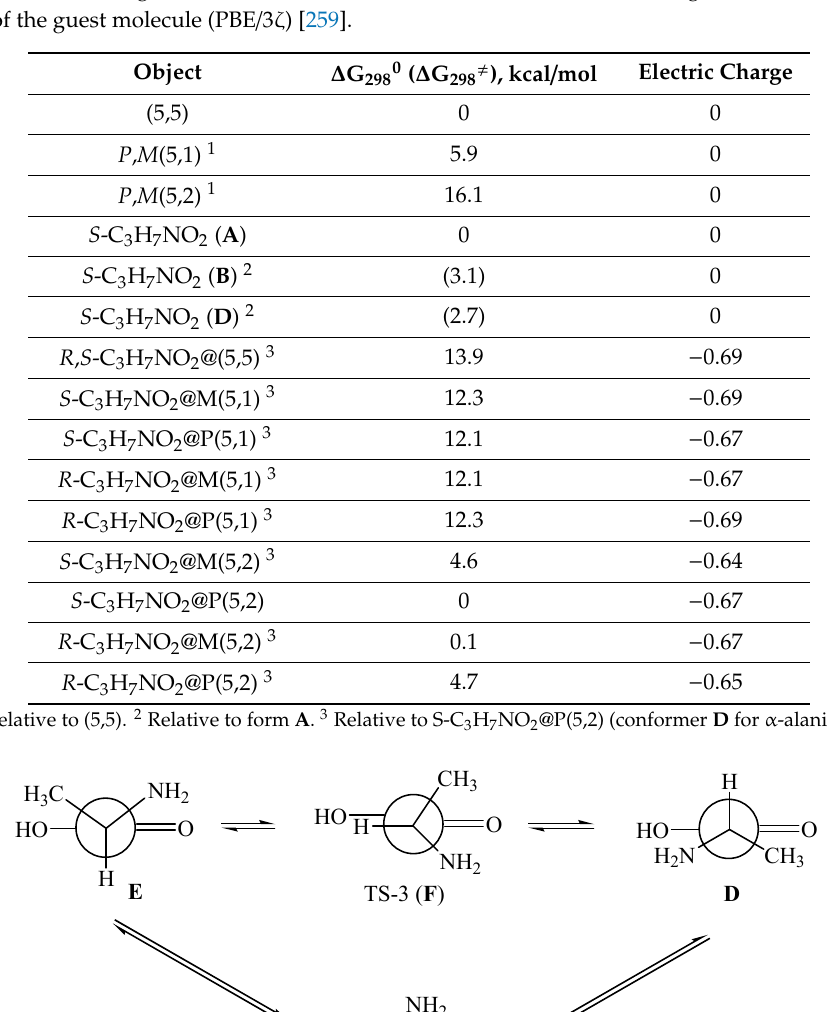
Comparison of clusters’ energy (Table 4) indicates that in a series of clusters with SWCNTs: (5,5), (5,1) and (5,2) their relative stability grows; the most stable are practically degenerated in energy endocomplexes S-C 3 H 7 NO 2 @P(5,2) and R-C 3 H 7 NO 2 @M(5,2) (Figure 19). Thus, the increase in chirality index m leads to a rise in the relative stability of the appropriate chiral clusters.